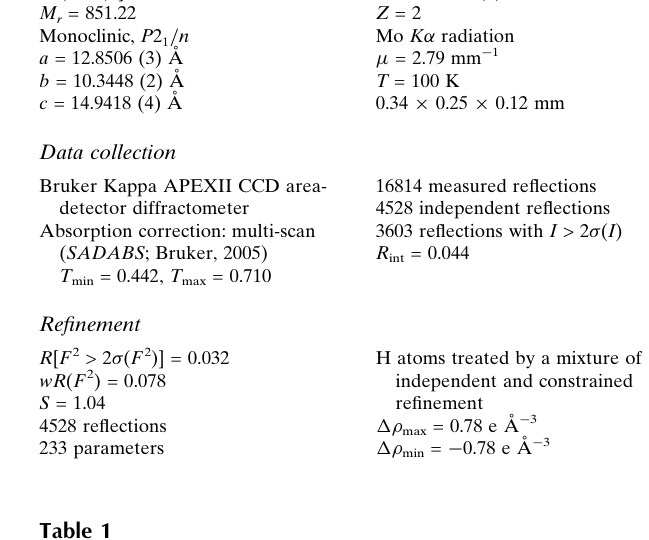
Bruker Kappa APEXII CCD area- detector diffractometer